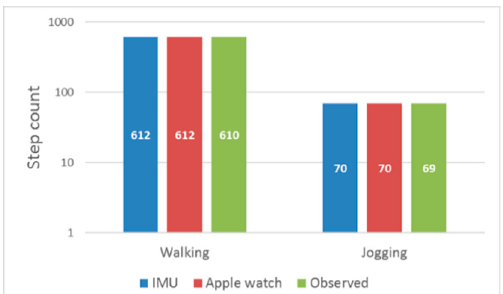
Figure 2. Mean step count measurements for all participants using the Apple watch and the IMU in walking and jogging. The data was validated by an observer count.